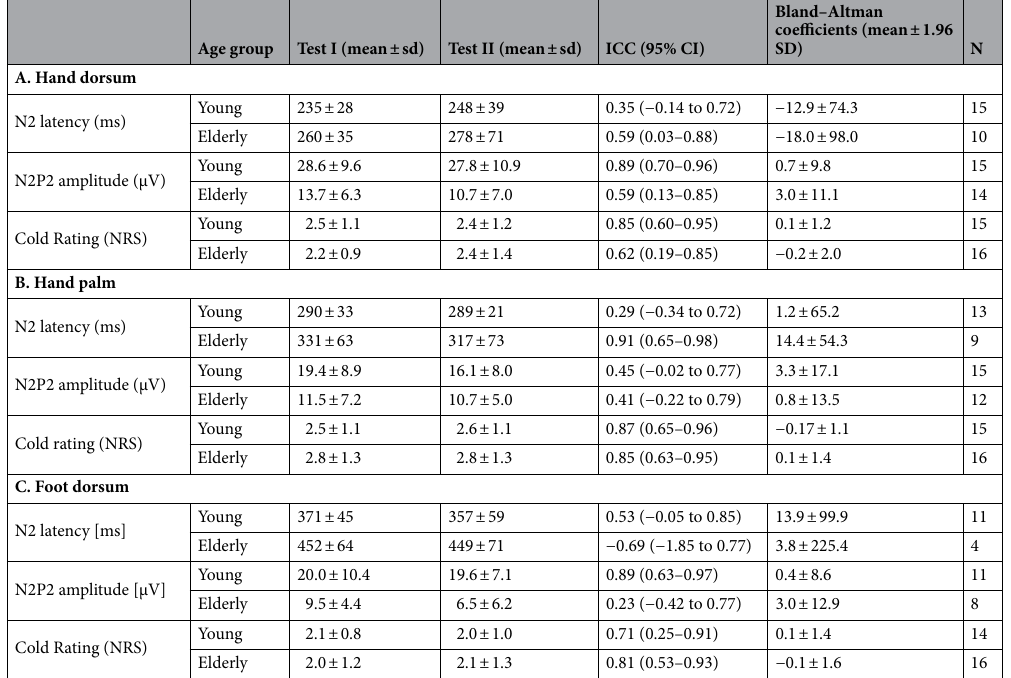
Table 1. Test–retest analyses. Mean ± standard deviation (sd) for N2 latencies, N2P2 amplitudes, and cold ratings. Test–retest statistics are shown as intraclass correlation coefficients (ICC) with 95%